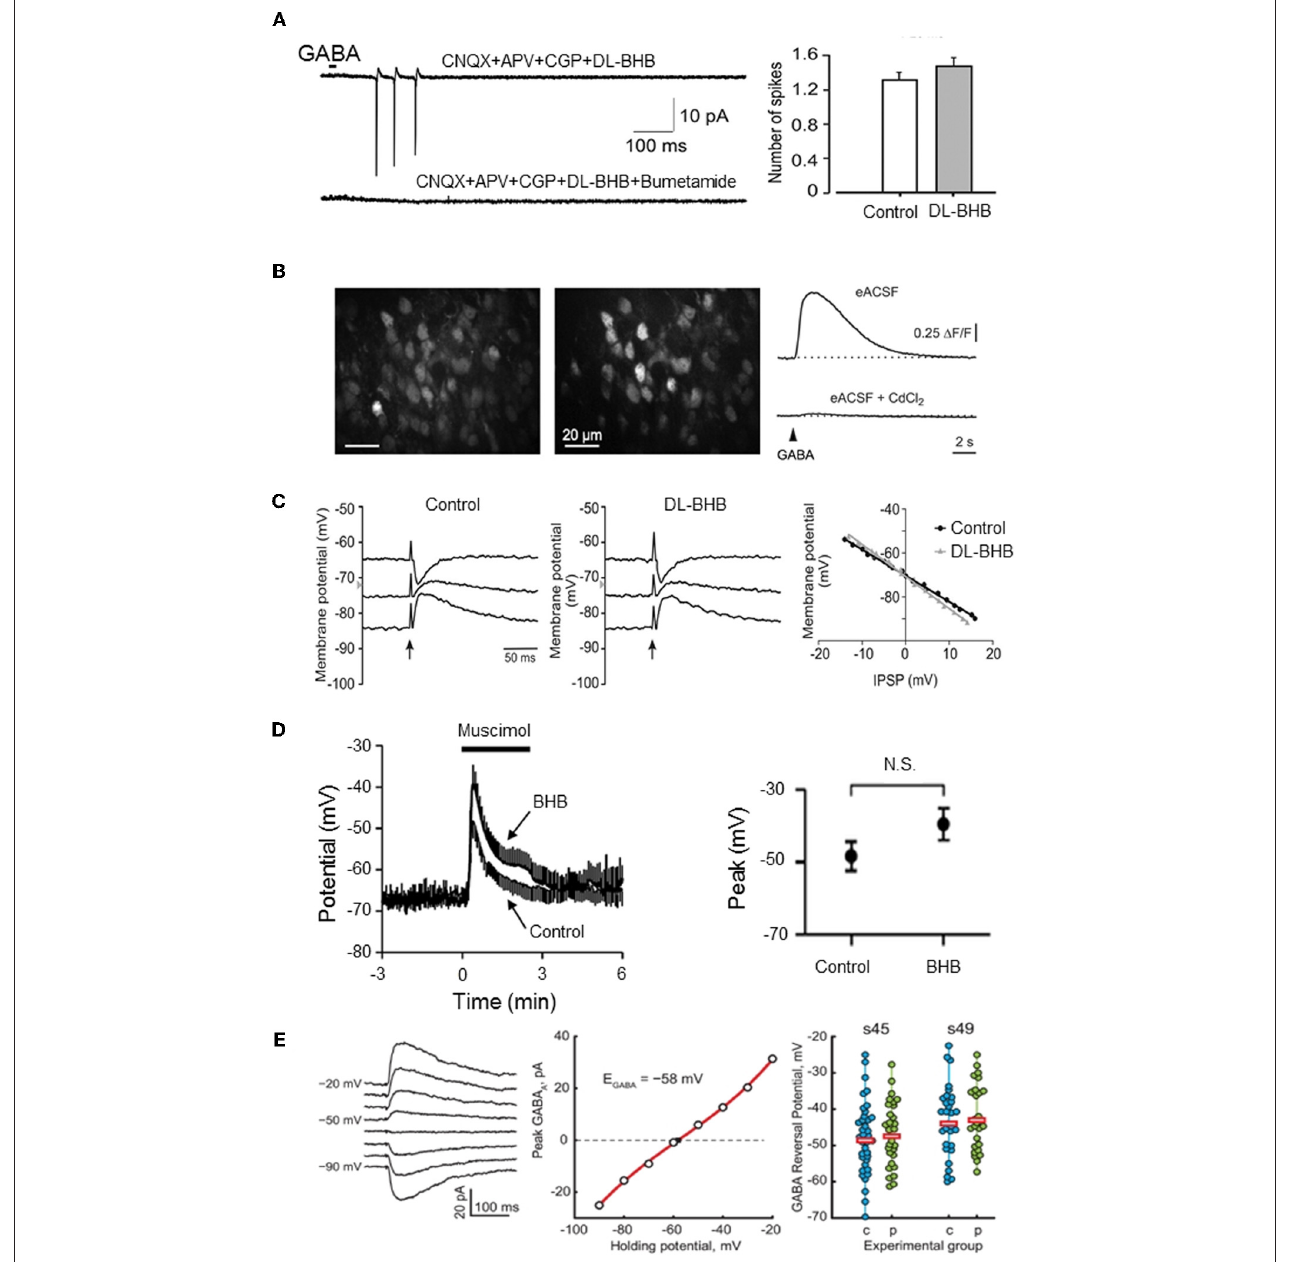
FIGURE 1 | Energy substrates do not affect E GABA or GABA actions in the immature neurons. (A) Energy substrates (DL-BHB, 4mM) do not alter the excitation produced by focal application of GABA in the neonatal rat hippocampus (cell-attached patch-clamp recording). Bumetanide (10 μ m) fully blocked the GABA response. [Modified from Tyzio et al. (2011)]. (B) Energy substrates (DL-BHB, 4mM) do not affect GABA-mediated Ca 2 + in neonatal cortical mice. Raw fluorescence image displaying OGB1-stained cells in the upper cortical plate (left) and (cid:2) F image illustrating GABA-responsive cells (middle). GABA-mediated somatic [Ca2 + ] transients persisted in BHB-conditions (right, upper trace) but was sensitive to CdCl2 (lower trace,100 μ m). [Modified from Kirmse et al. (2010)]. (C) Energy substrate (DL-BHB, 4mM) do not affect E GABA / Gly in lumbar spinal cord motoneurons (P0–P5 rats). IPSPs evoked by electrical stimulation of ventral funiculus ( vertical arrows ) at different holding potentials in MNs from P4 rat in control